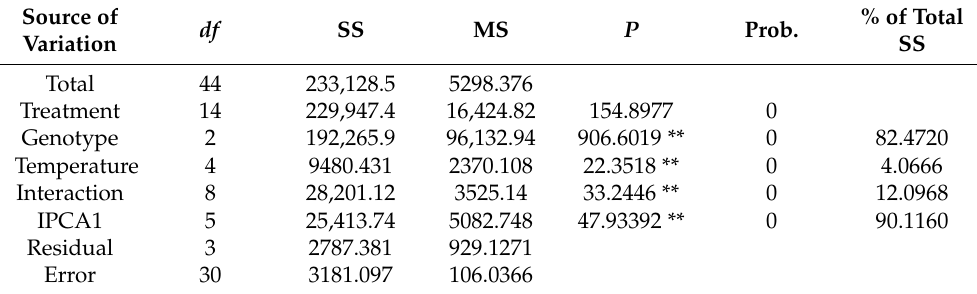
Table 4. AMMI analysis results of antioxidant enzyme activities for different temperatures trials.